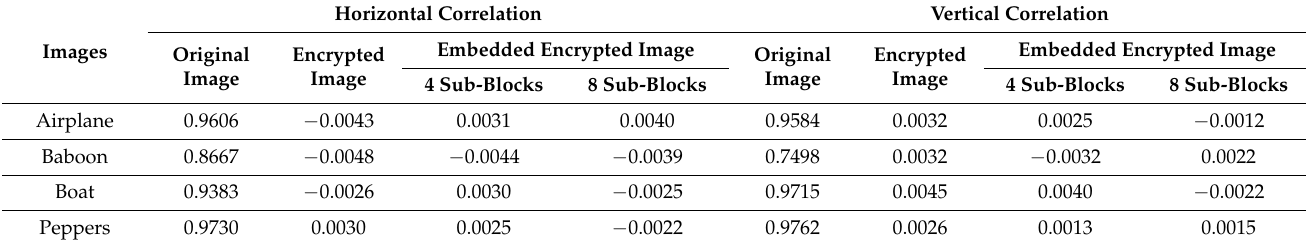
Table 6. Correlation distribution of images in different directions when the pixel block size is 4 × 4.